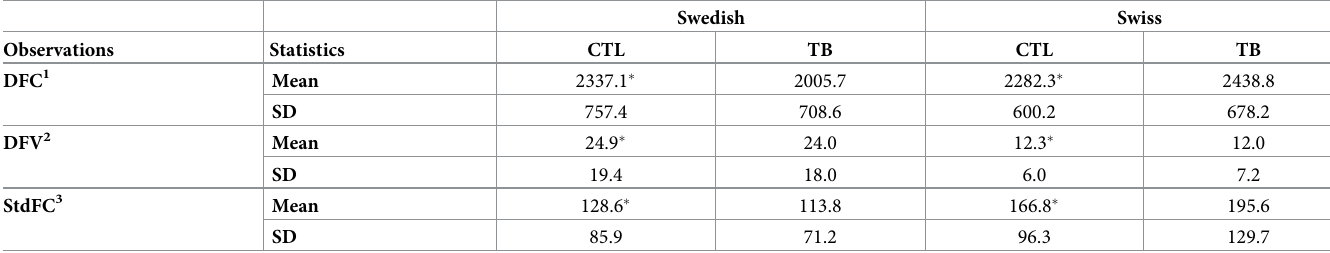
Table 2. Characteristics of the data